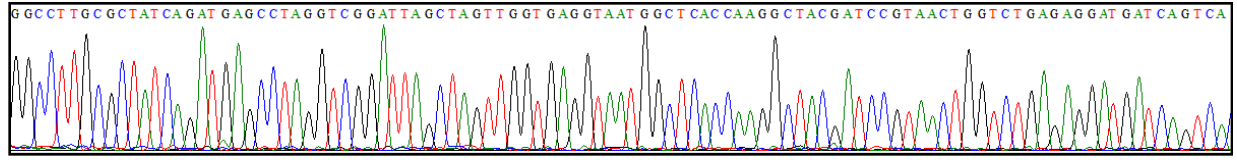
The 16S rDNA sequences obtained allowed to identifying five Pseudomonas species in